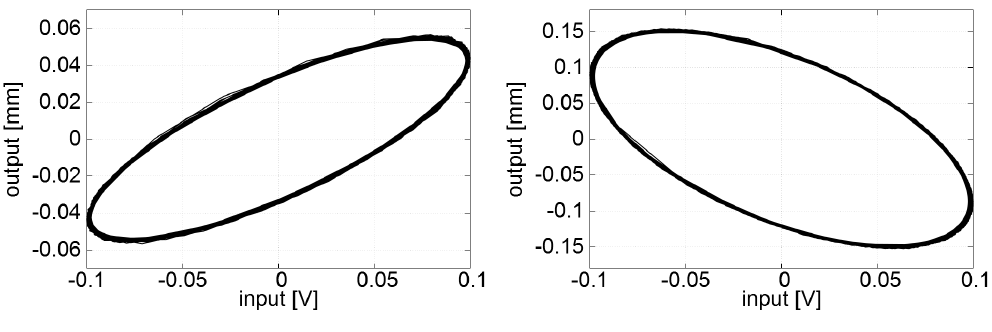
Figure 15. Hysteresis loops of the actuator for ( a ) 66 Hz and ( b ) 69 Hz input sinusoids. Loop ( a ) is a commonly observed loop whereas the polarity is inverted in loop ( b